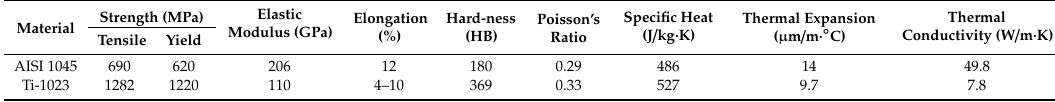
Table 1. Mechanical and thermal properties of test materials